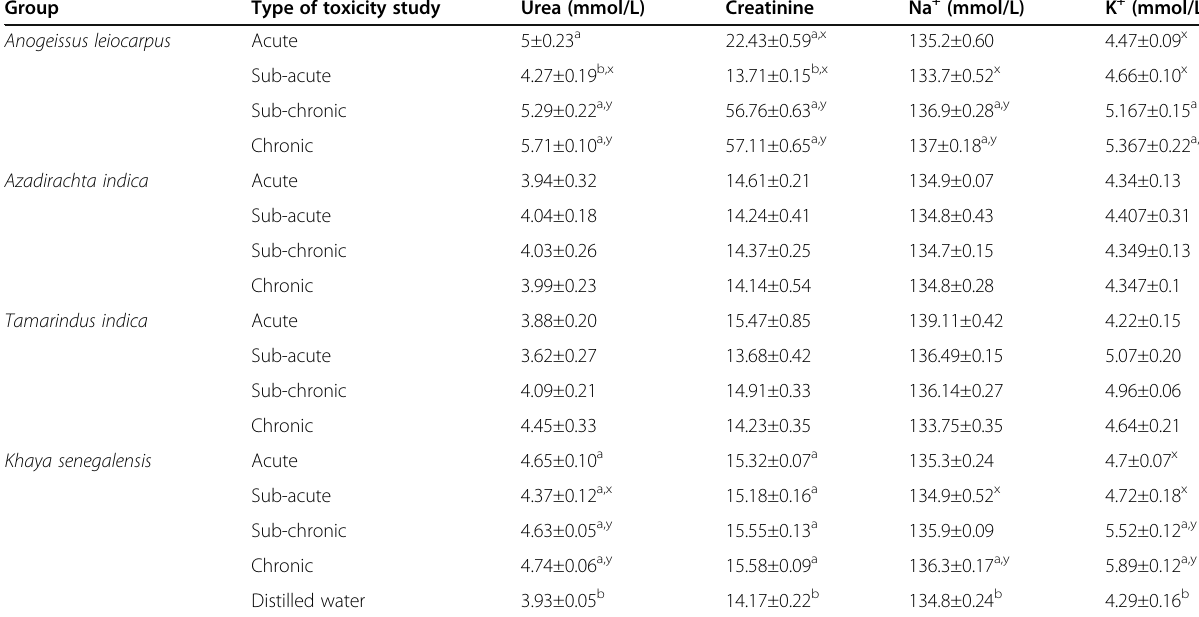
Table 5 Effects of prolonged oral administration of extracts of four ethnomedicinal plants in rats on kidney function assay